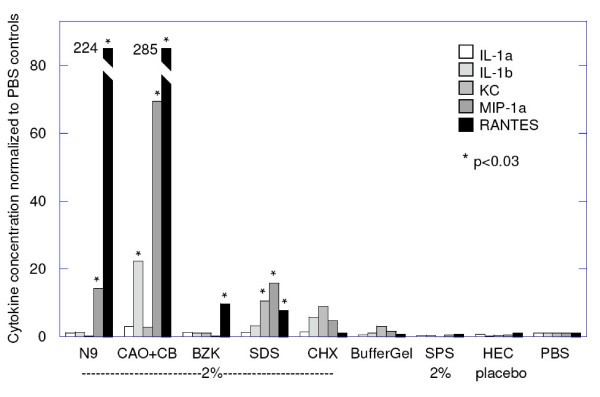
Inflammatory cytokines 12 hours after a single exposure to candidate microbicides. Geometric means for each agent are shown normalized by the results in PBS controls as follows, in ng/ml of lavage fluid: IL-1α, 16; IL-1β, 50; KC, 42; MIP-1α, 20; RANTES, 3. Thus N9 increased the concentration of RANTES 224-fold, from 3 to 672 ng/ml in lavage fluid. (The lavage procedure is estimated to have diluted vaginal secretions by 10–50-fold.) (CAO+CB) = 1%CAO+1%CB = 2% detergent.